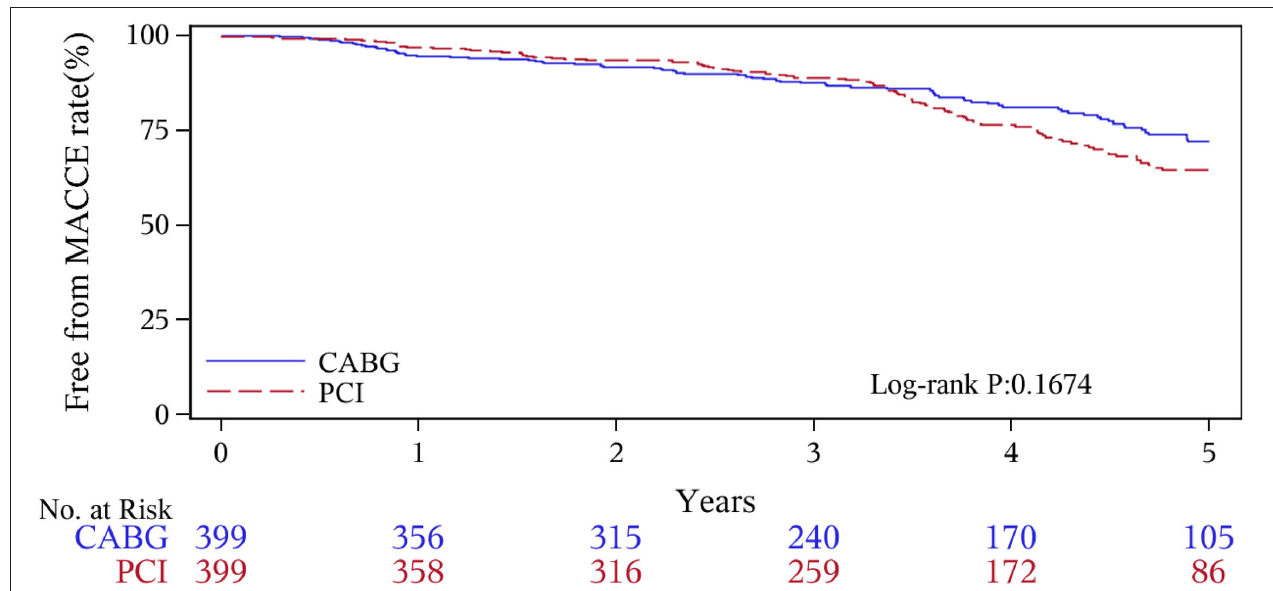
FIGURE 5 | Major adverse cardiovascular event (MACCE) Kaplan–Meier (1–5 years).